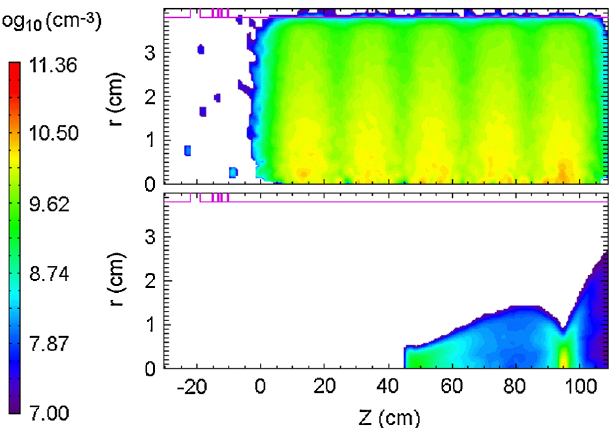
FIG. 25. (Color) f r; z g isocontours of ferroelectric plasma den- (top) and beam density n sity n p focal plane at t (cid:6) 6320 ns . Both plots are on the same log scale.